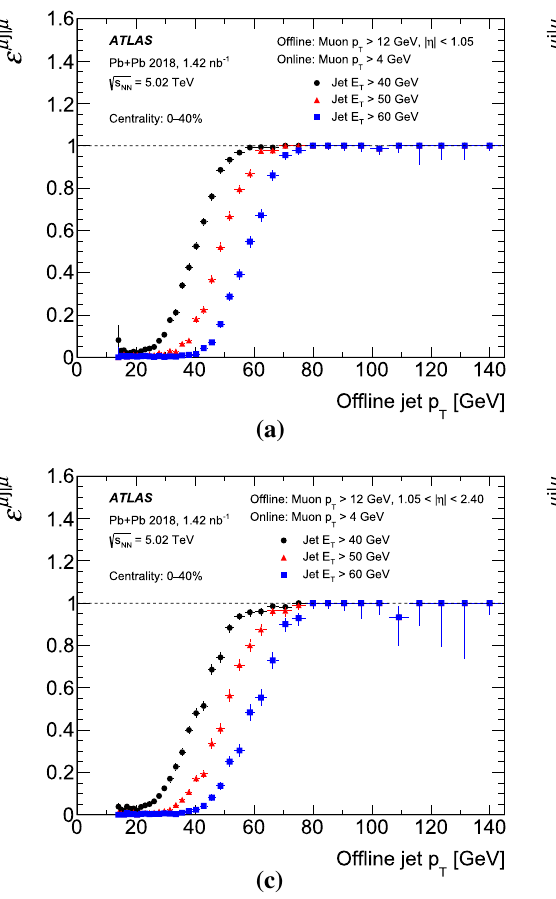
required to have an offline muon with p T more than 12GeV. The last bin contains overflow. The performance is shown in the a , b barrel and c , d endcap regions of the detector, for ( a , c ) central collisions (0–40%) and b , d peripheral collisions